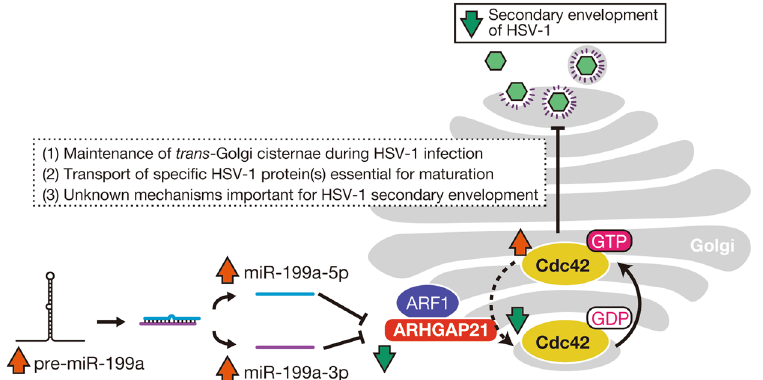
Figure 8. A possible pathway for pre-miR-199a-mediated regulation of HSV-1 secondary envelopment. Dashed lines denote hypothetical mechanisms. Both miR-199a-5p and miR-199a-3p generated from pre-miR-199a inhibit ARHGAP21 protein synthesis, resulting in the accumulation of GTP-binding Cdc42 (activation) in the Golgi apparatus. This activation would disturb secondary envelopment of HSV-1. Disturbance of secondary envelopment may be due to low efficiency in maintenance of trans -Golgi cisternae during HSV-1 infection, transport of some HSV-1 protein(s) essential for virion maturation, or unknown